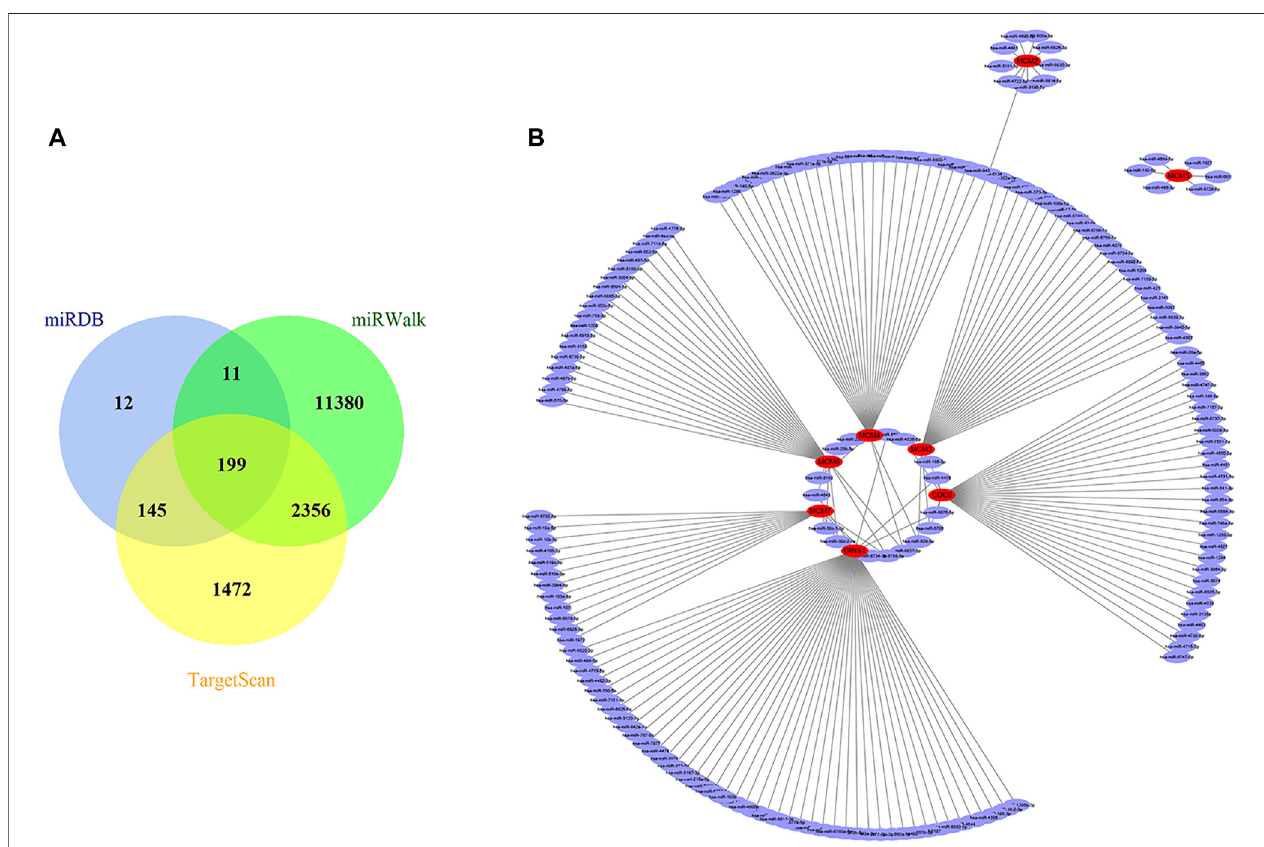
FIGURE 6 | Prediction of targeted miRNAs. (A) Venn diagram of the common predicted miRNAs. (B) The miRNA-mRNA network constructed based on the predicted relationship. Red represents the mRNAs, and purple represents the miRNAs. MiRNAs, microRNAs; mRNAs, messenger RNAs.